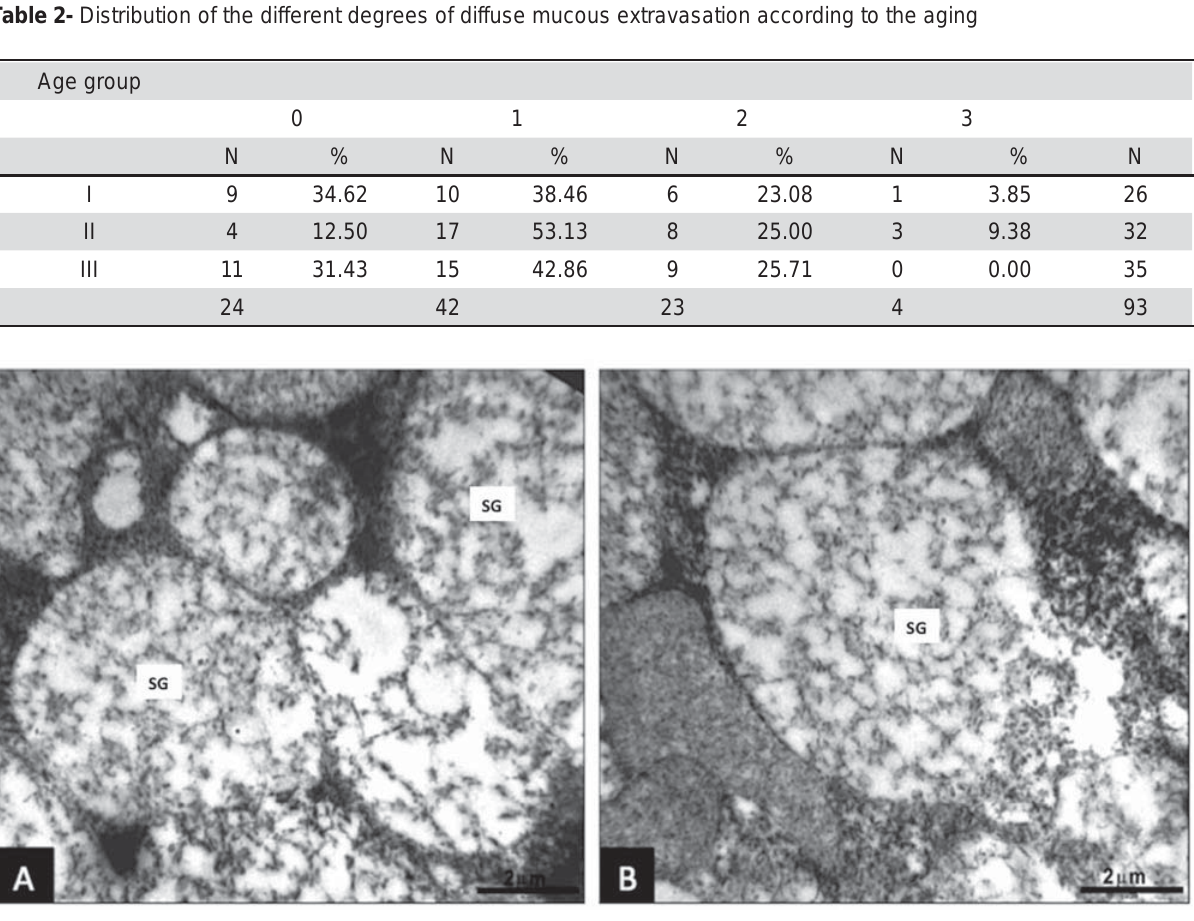
Table 2- Distribution of the different degrees of diffuse mucous extravasation according to the aging